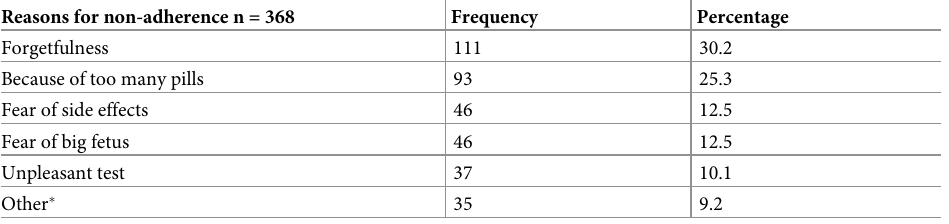
Table 4. Reasons for non adherence among ANC attending pregnant mothers in governmental health institution of Adwa town, Ethiopia, 2018. Reasons for non-adherence n =